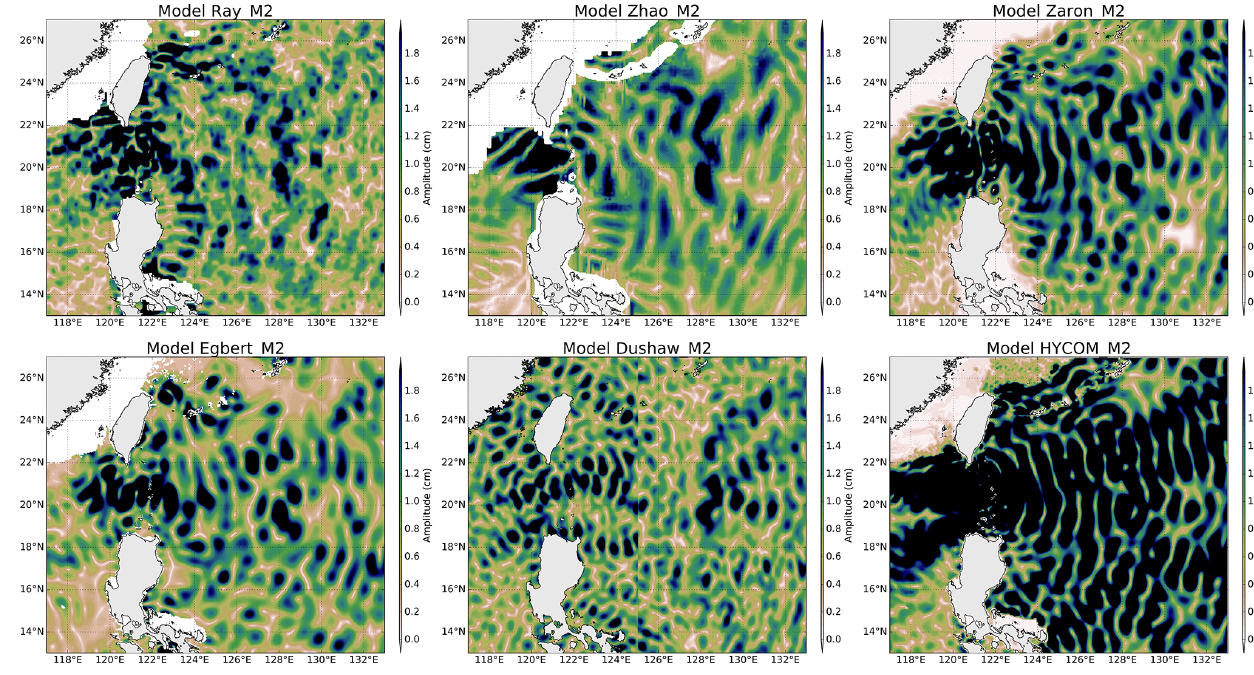
Figure 3. Amplitude of the IT models for the M 2 tide component in the Luzon area.